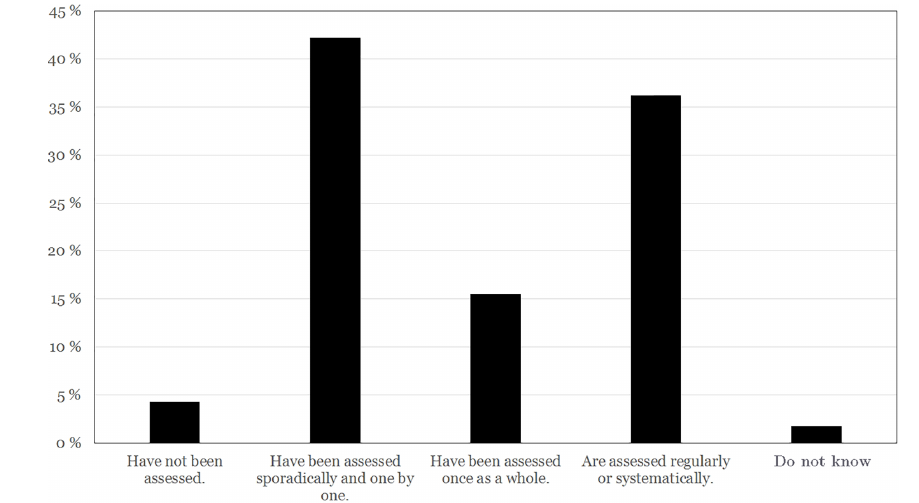
Figure 2. The respondents’ view on question: “How has your organization assessed current and expected weather and climate risks?” (Appendix A, Question